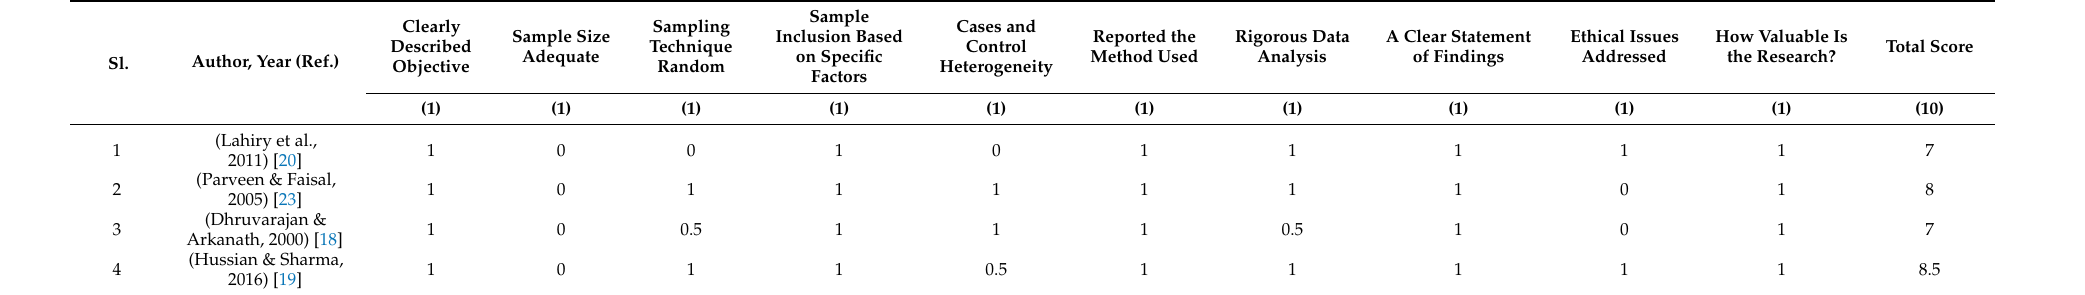
Table A2. Case-control